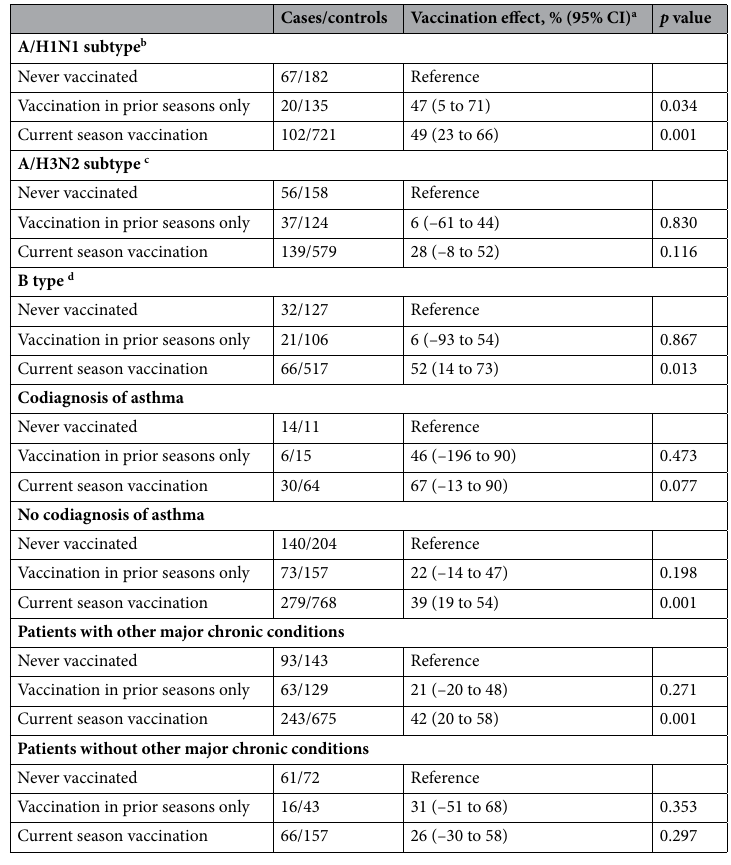
Table 3. Effect of influenza vaccination status in the current and 5 prior seasons in preventing laboratory- confirmed influenza among patients with chronic obstructive pulmonary disease by (sub)type and presence of other major chronic conditions. CI confidence interval. a Vaccination effect adjusted by age groups